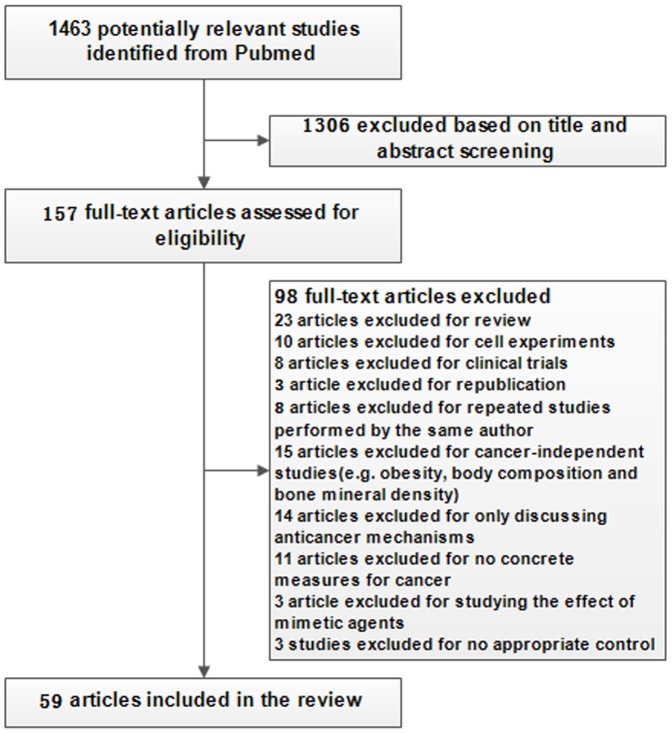
Flow chart of the selection of studies included in the system review.